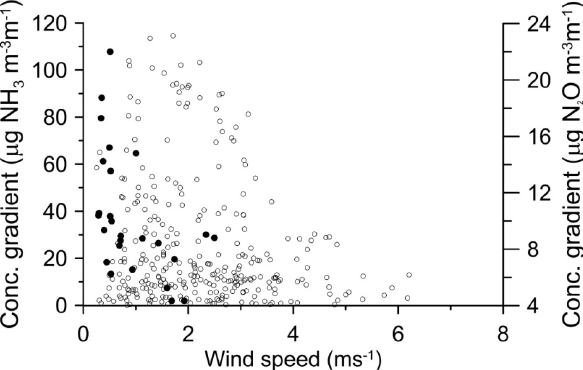
Fig. 5. Variation in concentration gradient relative to horizontal wind speed. Values in both the Indiana (NH 3 , open circles) and Fuhrberg (N 2 O, closed circles) experiments are indicated.